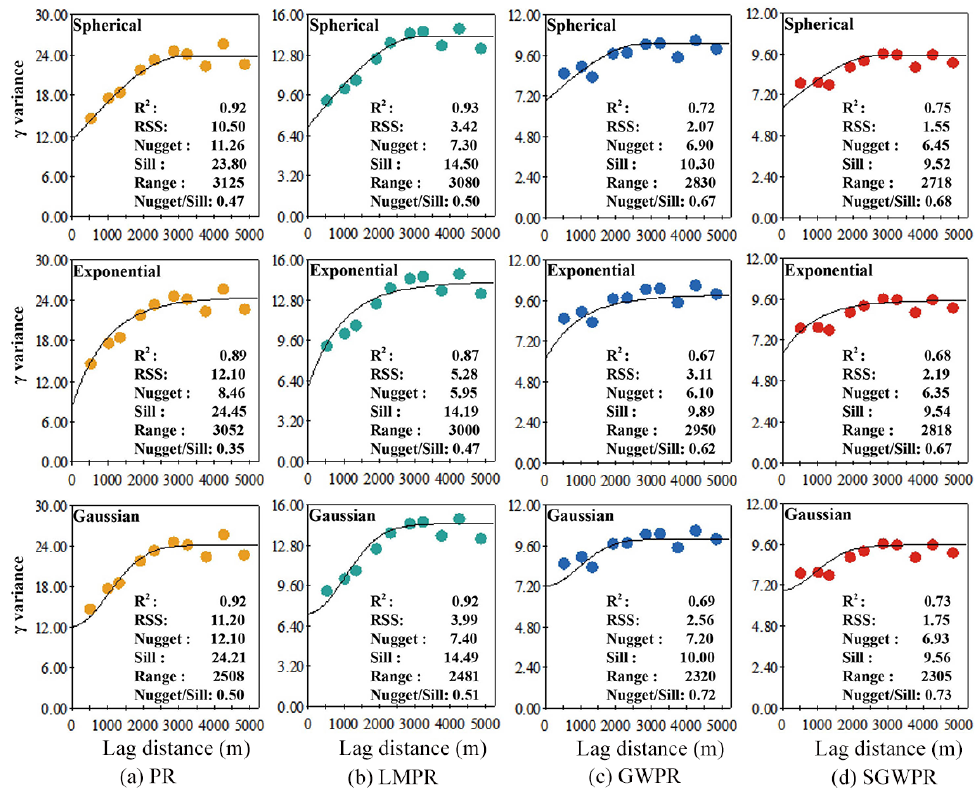
Figure 5. The nugget, sill, and nugget/sill parameters of the analysed global and local models, including the models built using spherical, exponential, and Gaussian functions. ( a ) PR represents the Poisson regression, ( b ) LMPR represents the Liner mixed PR, ( c ) GWPR represents the Geographically weighted PR, and ( d ) SGWPR represents the semiparametric GWPR. Note: The black line in the figure is a Spherical, Exponential and Gaussian fitting line.